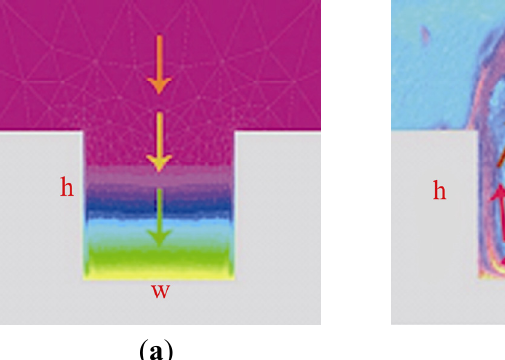
Figure 1. Courtyard’s vertical section. In grey colour: building section. In others colours: air at different temperatures. ( a ) Stratification; ( b ) Convection; ( c ) Flow patterns (Images from the CFD